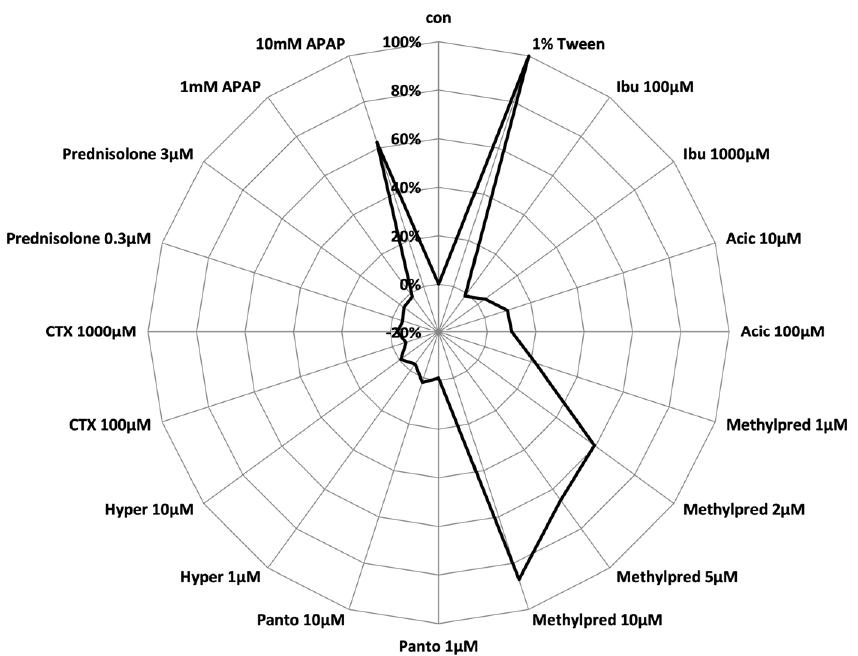
Figure 1. Example of an MH cell test result. The spiderweb graph shows the toxicity results in a patient with suspected DILI. Methylprednisolone as the likely cause of DILI in this case (causality assessment: highly likely with a positive rechallenge) induces toxicity of 60% at 2 × C max , of 66% at 5 × C max and 87% at 10 × C max . No toxicity of the comedication with ibuprofen, acyclovir, pan- toprazole, hyperforin (a herbal remedy), ceftriaxone or prednisolone, which was used to treat the DILI episode, was observed in MH cell testing in this patient. APAP is a standard part of the test for demonstrating dose-dependent drug-induced liver injury. Lysis with 1% TWEEN ® 20 (polyeth- ylene glycol sorbitan monolaurate) is used as a positive control. Abbreviations: Acic: Acyclovir;